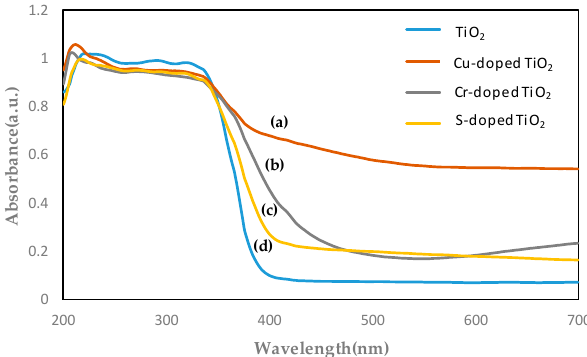
Figure 13. UV-visible absorption spectrum of specimens: ( a ) Cu-doped TiO 2 ; ( b ) Cr-doped TiO 2 ; ( c ) S-doped TiO 2 ; ( d ) TiO 2 .